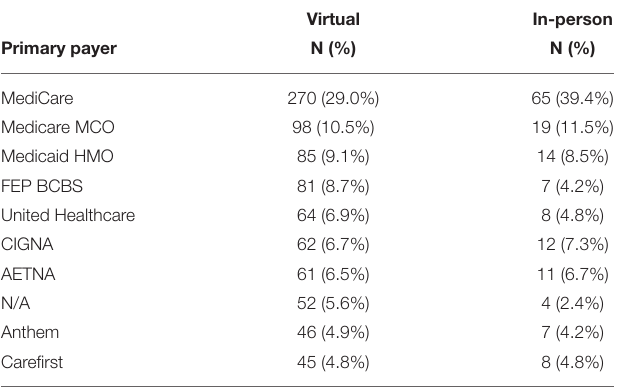
TABLE 3 | Payer by visit type.